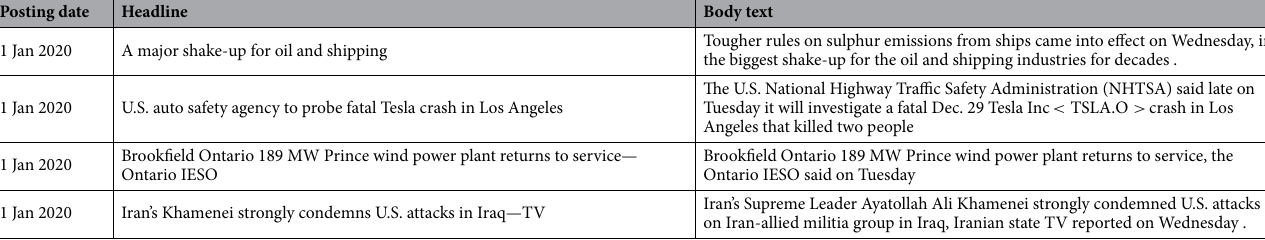
Table 2. Examples of news